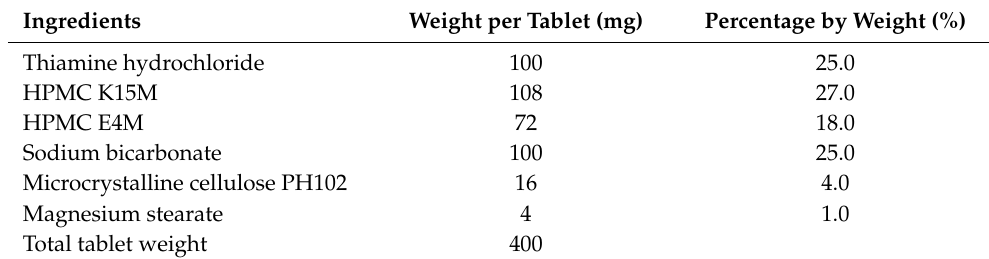
Table 1. Formulation of the thiamine hydrochloride floating